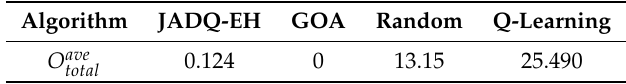
Figure 8. O total comparison of different algorithms under scenario 2. Table 6. O ave comparison of different algorithms under scenario total